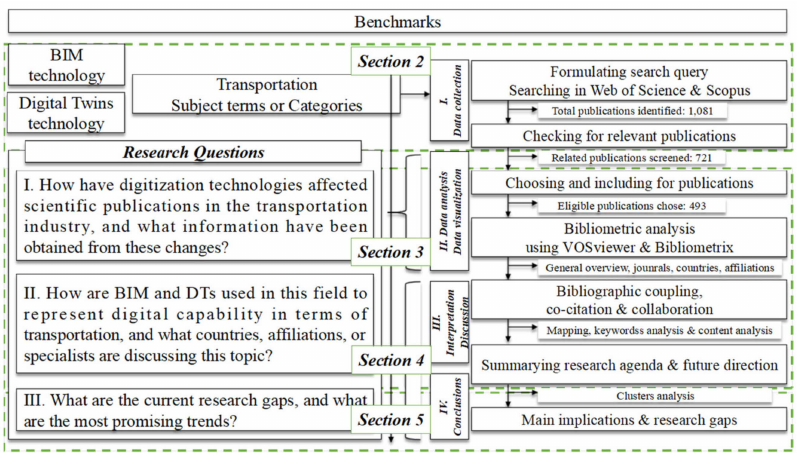
Figure 2. Research framework design. Table 1. Collecting the final data results for